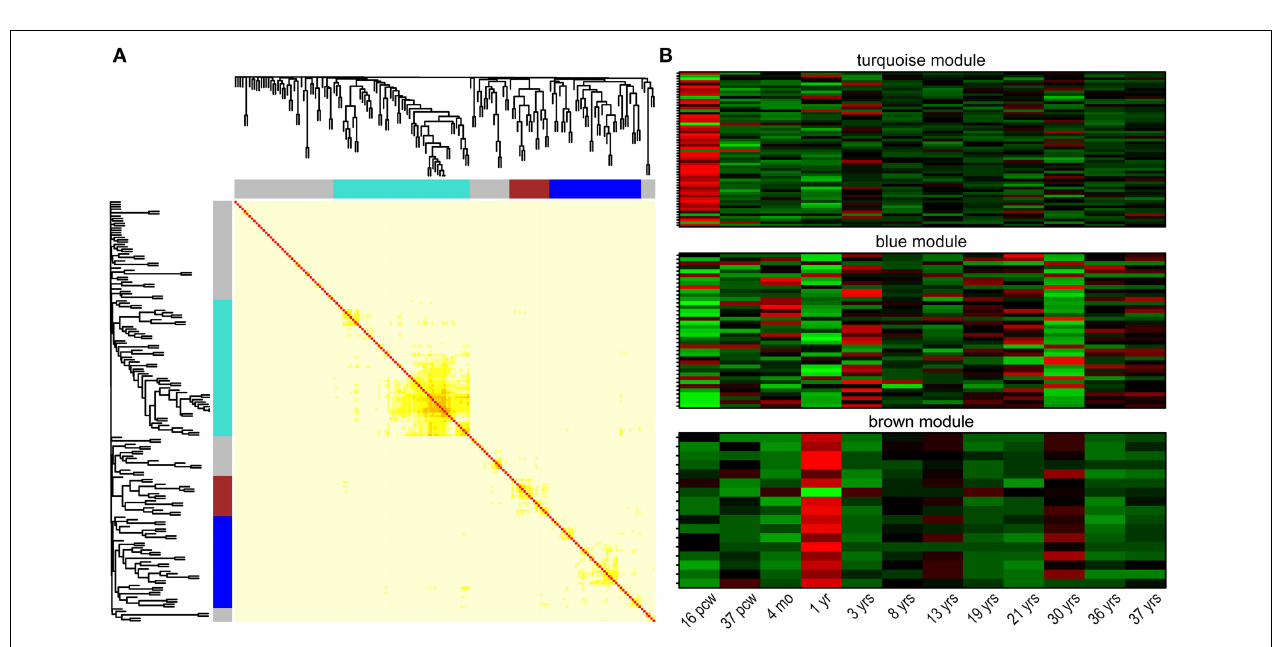
FIGURE 4 | Co-expression clusters among NHGRI-cross-disorder genes. (A) Topological overlap matrix plot (TOMplot), a heatmap depicting the topological overlap matrix supplemented by hierarchical clustering